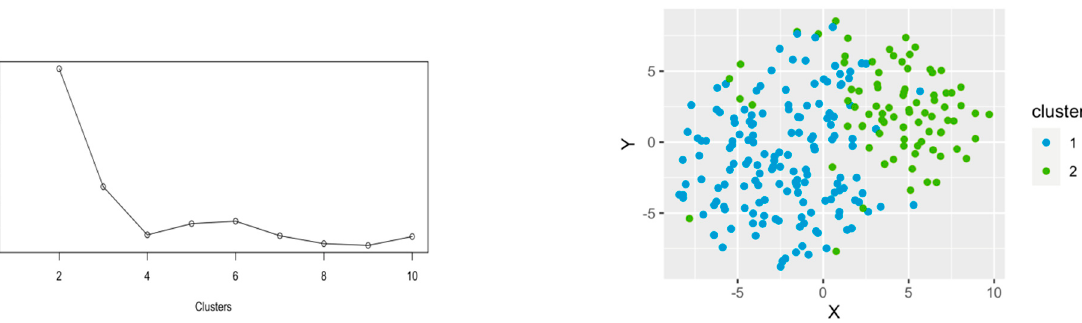
Figure 1. Optimal number of clusters with Silhouette Width and Cluster plot (k = 2). Source: compiled by the authors.